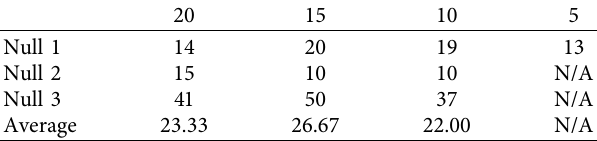
Figure 12: Average normalized power in the nulling directions against the count of nodes. Table 10: Null width (in degrees) corresponding to null steering using 20, 15, 10, and 5 nodes. Te null width has been measured at the − 20dB power level in the average array factor.